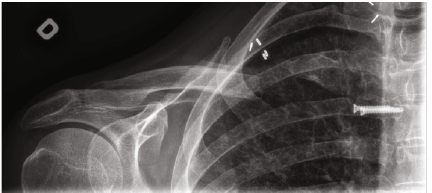
Figure 6: Clavicle radiograph three years postreconstruction surgery. Two remaining screws are super fi cial to the